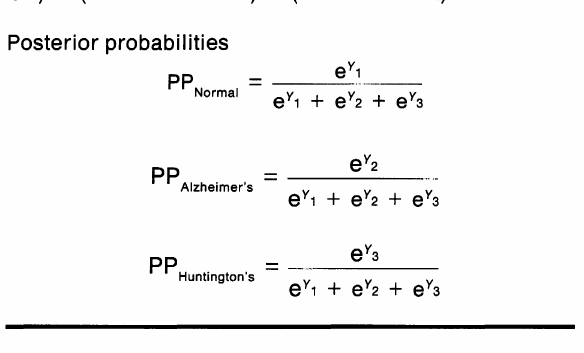
TABLE III. Classification matrix results Classified as: AD-like HO-like